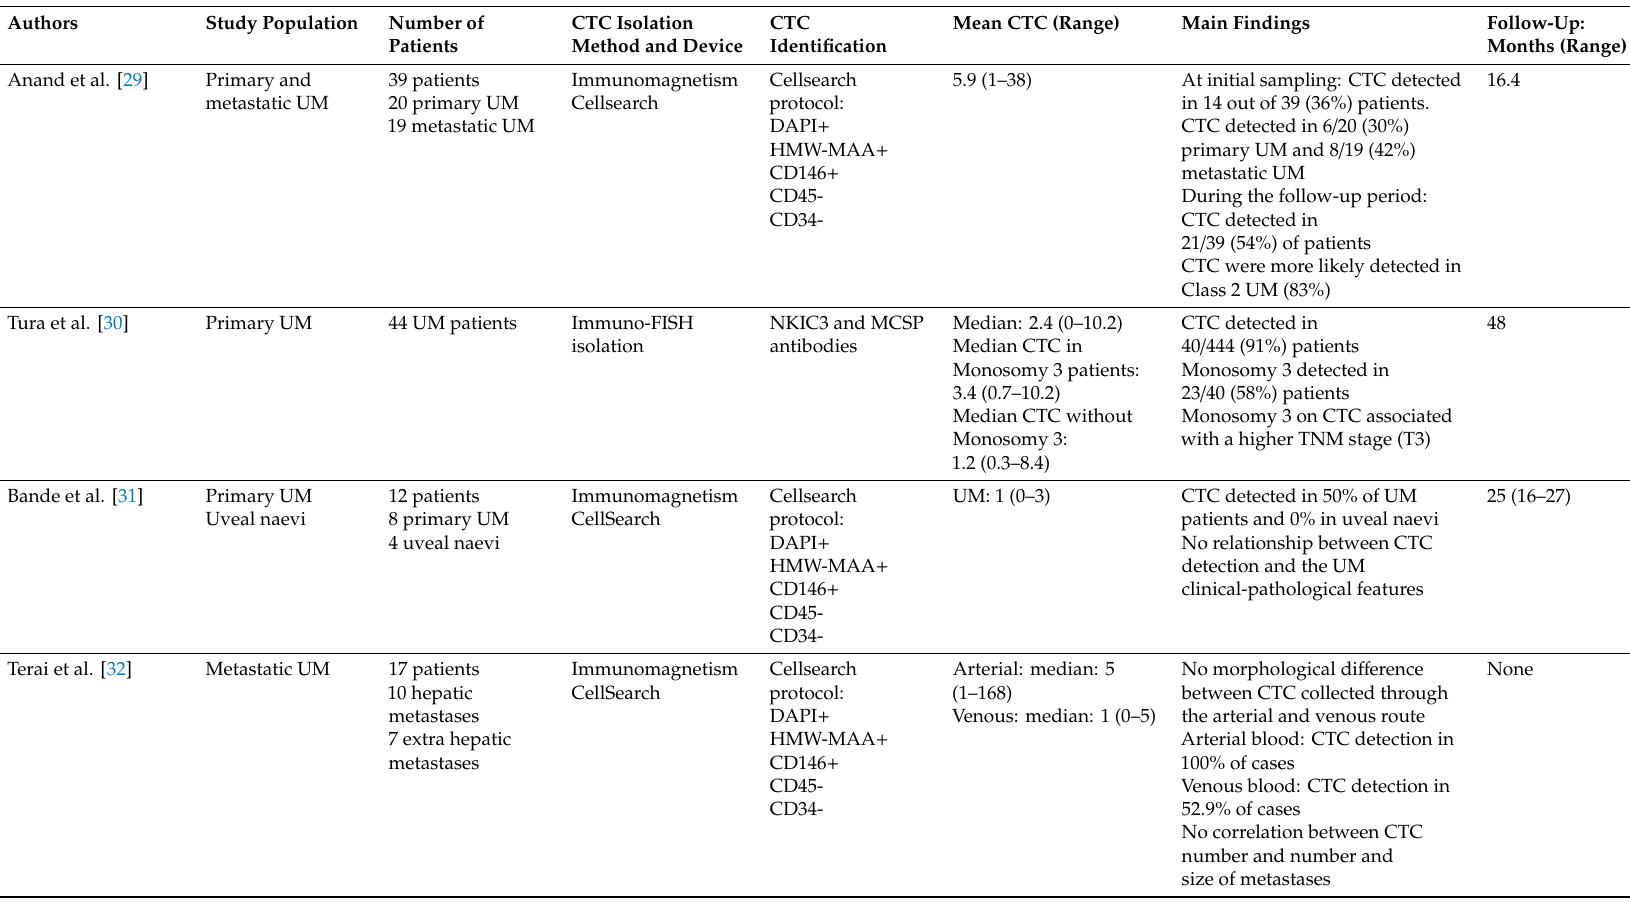
Table 2. Summary of the main studies investigating circulating tumor cells (CTCs) in uveal melanoma